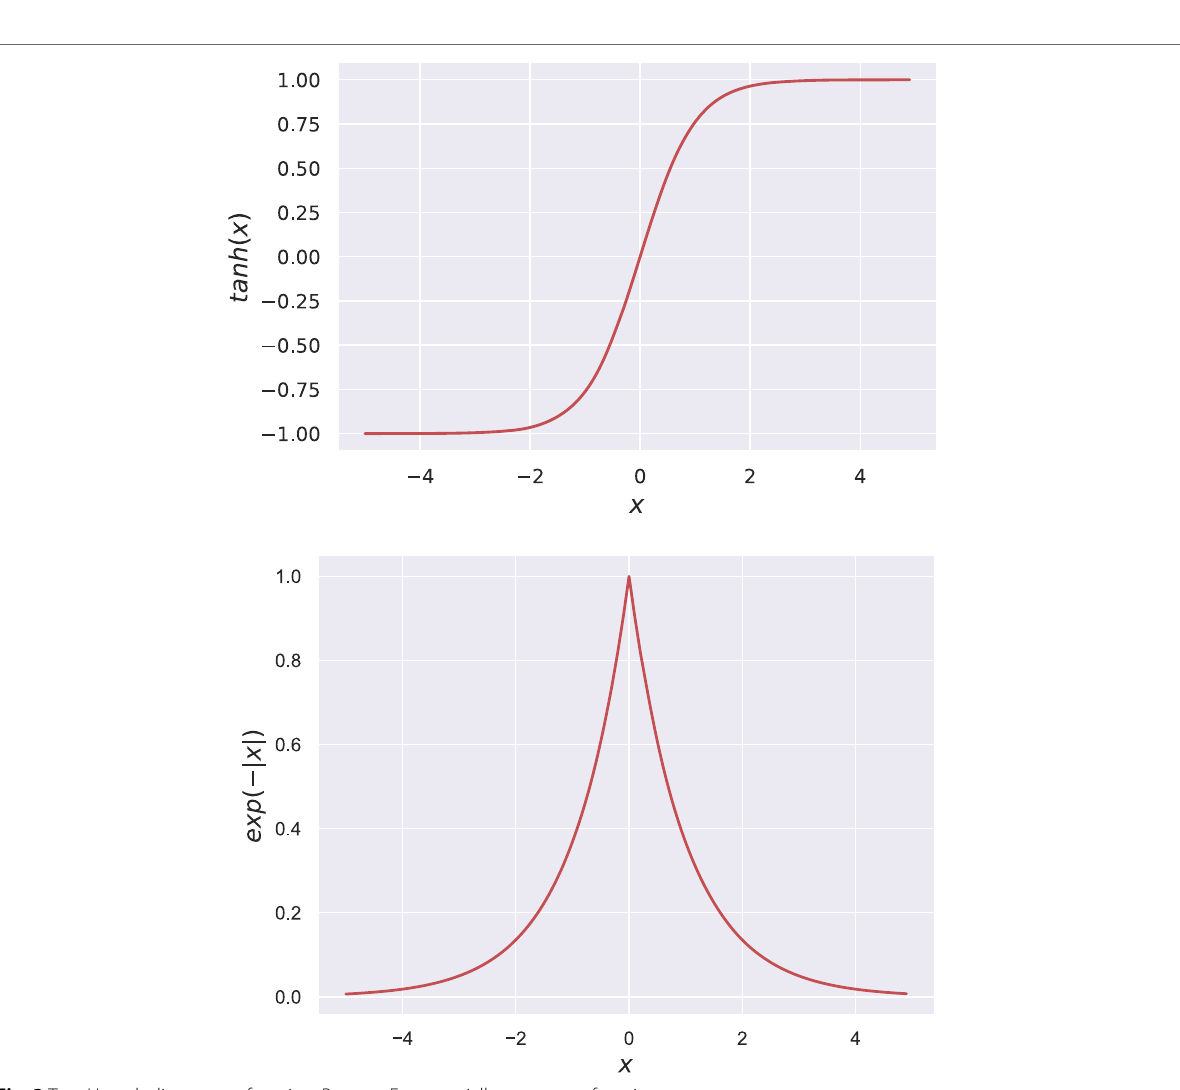
the target level. A value of -1 indicates a resource that is at the extreme of under-utilization and a value of +1 indi- cates a resource at the extreme of over-utilization. Given this range of values for both the computing resources and an overall value for the machine allows customers to diag- nose possible issues with the machine and/or resource